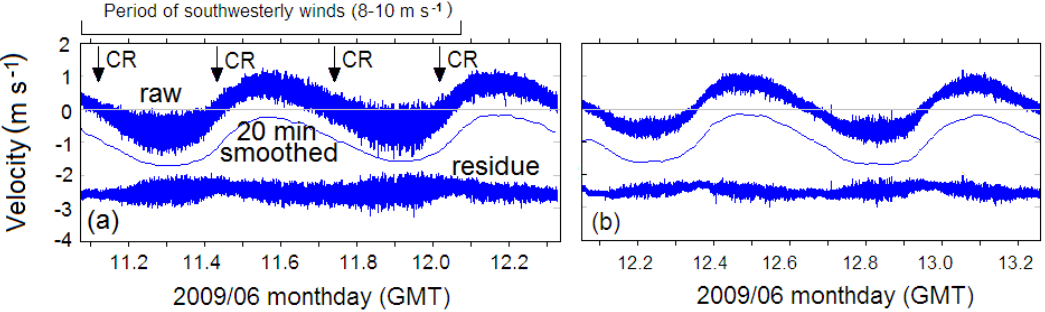
Fig. 5. 28-h samples of along-shore velocity at mid-depth (10m.a.b.) during the storm on 11 June 2009 (a) and the calm period on 13 June 2009 (b) . For the storm period, sustainable southwesterly winds were observed (the corresponding period is shown on the top of Fig. 5a). CR matches the current reversal. Negative velocity between two CR stands for ebb flow opposed to wind and wind-generated surface waves). Time is shown as a fraction of the day on